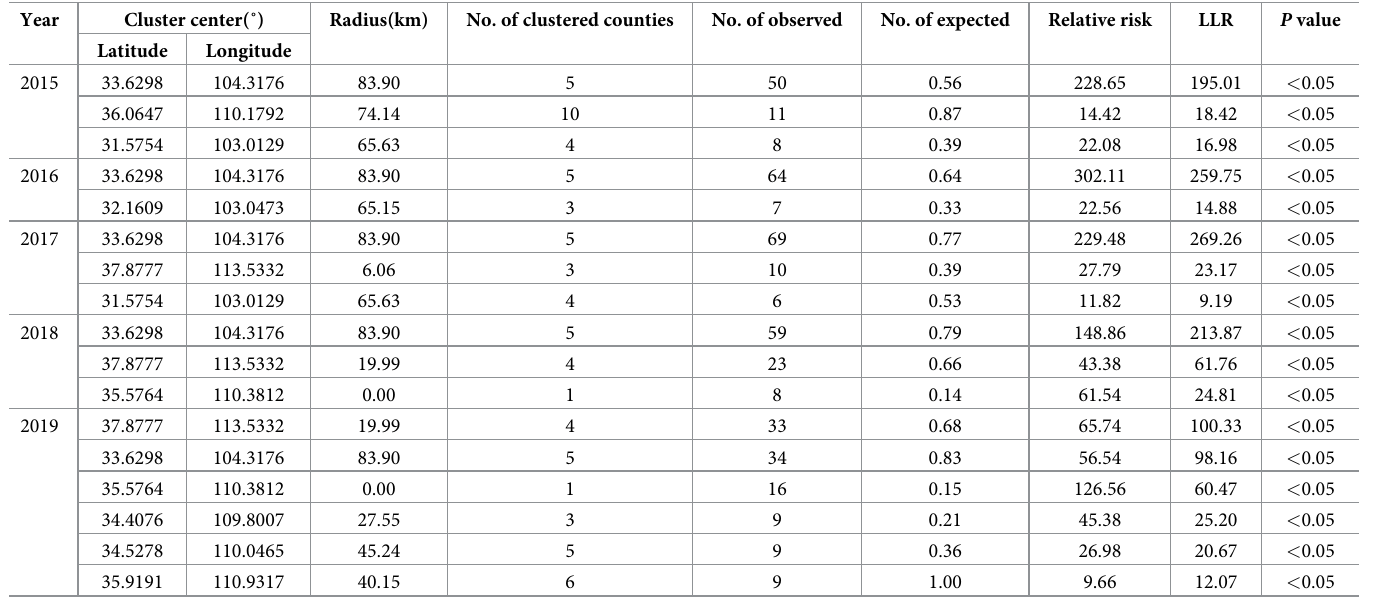
Table 3. Spatiotemporal clustering analysis of mountain-type zoonotic visceral leishmaniasis incidence in 6 provences, China from 2015 to